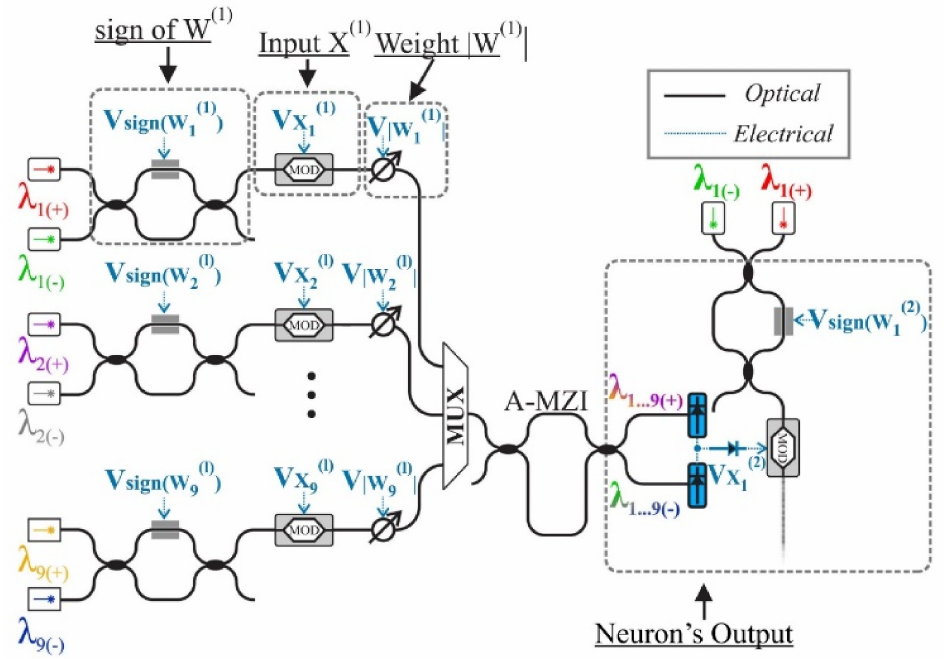
Figure 16. The operation principle of a neuron in an optical materialization